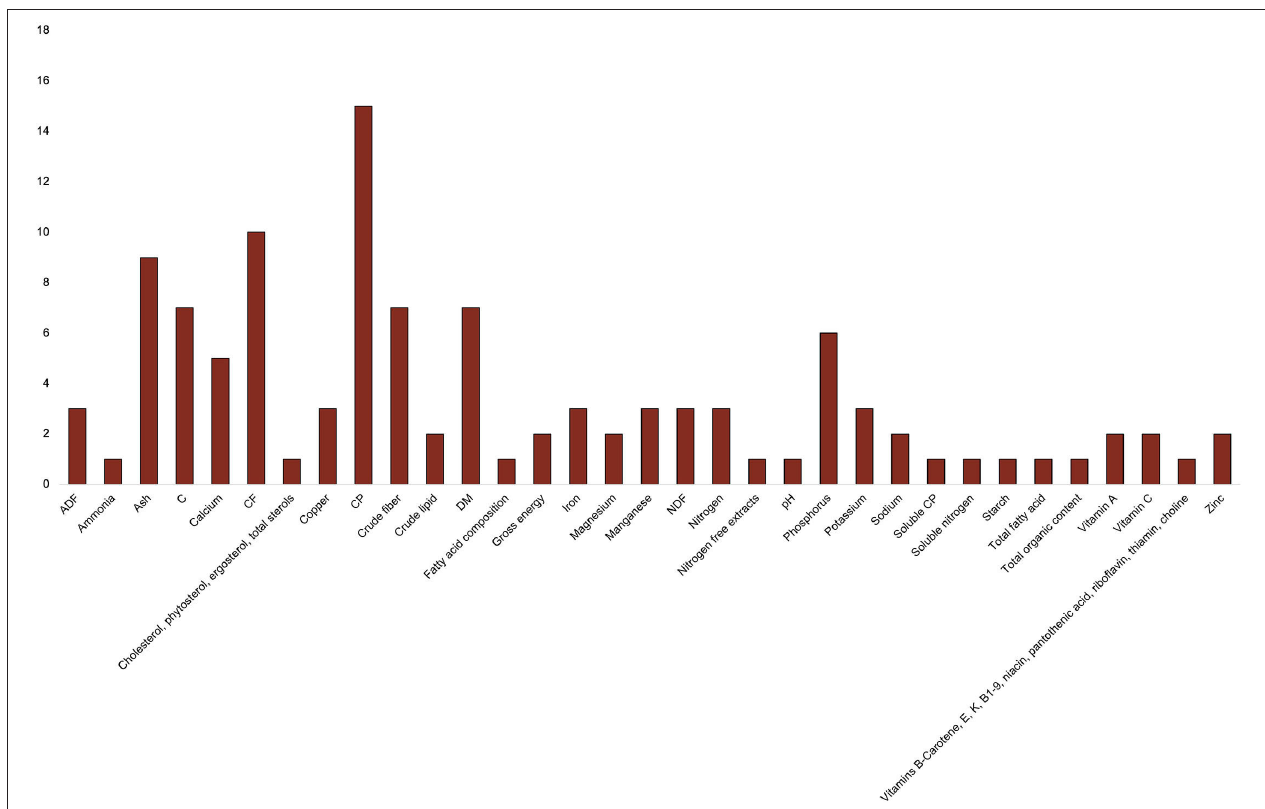
FIGURE 4 | Frequency of feed nutrients measured across studies. ADF, acid detergent fiber; C, carbohydrate; CF, crude fiber; CP, crude protein; DM, dry matter; NDF, neutral detergent fiber.